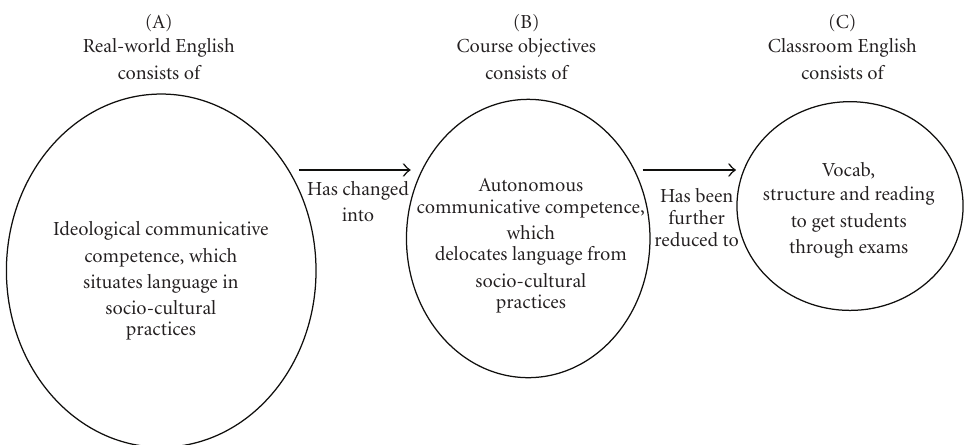
Figure 2: Double recontextualisation of the English